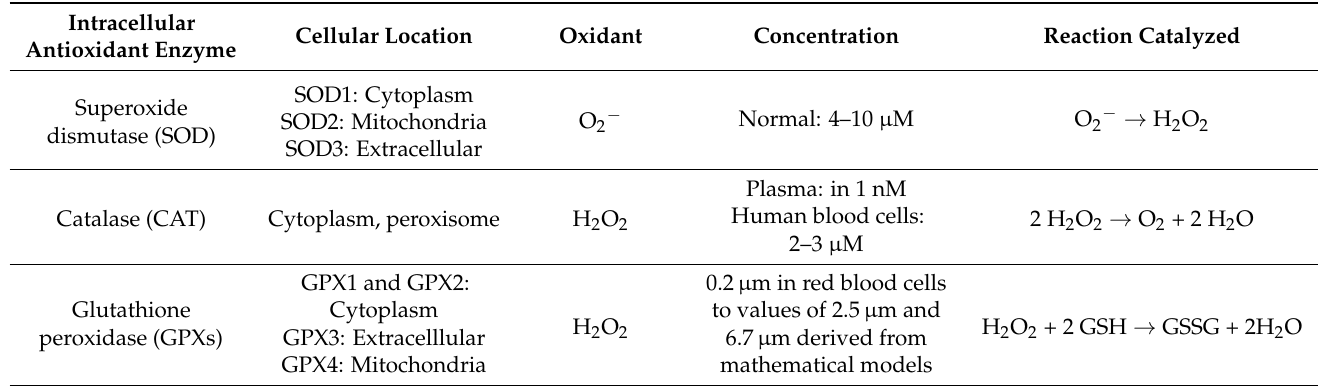
Table 2. Reactions catalyzed by various intracellular antioxidant